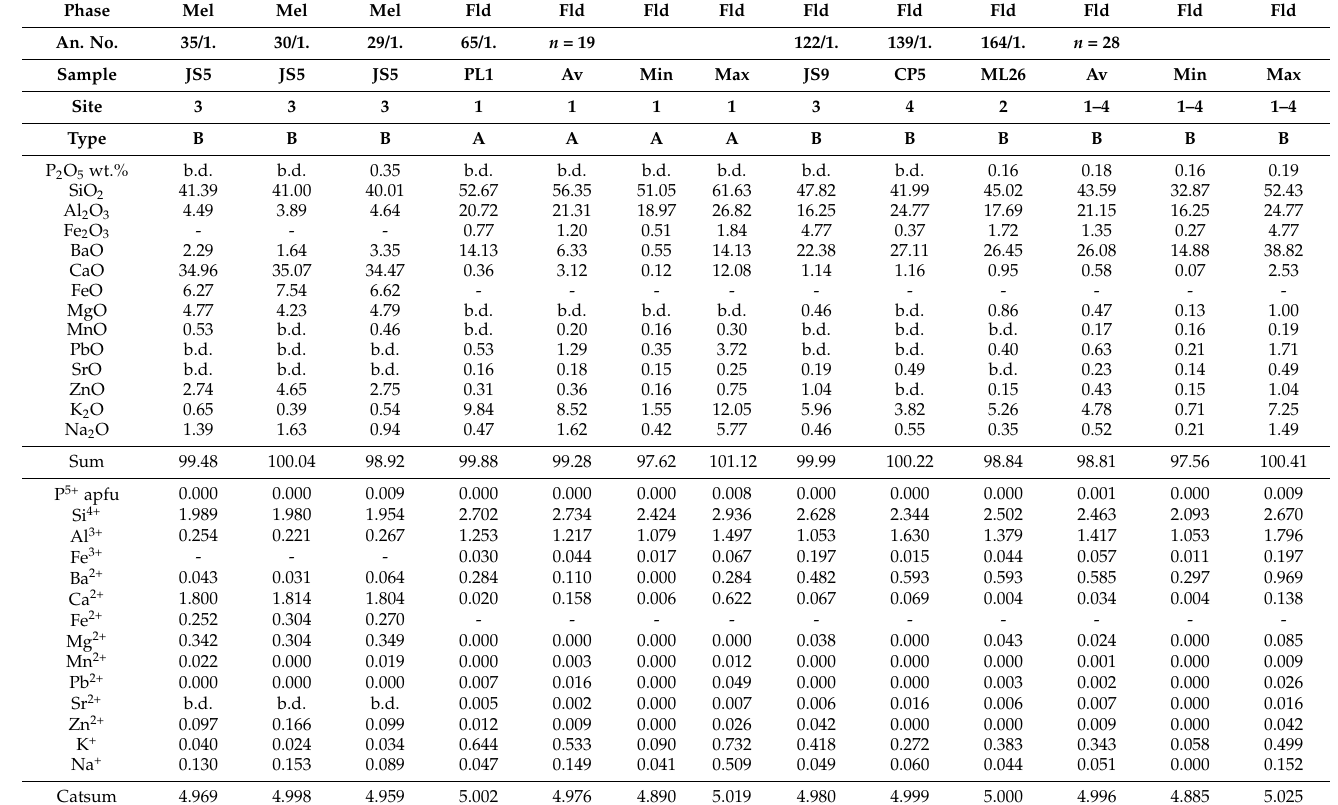
Table 4. Representative compositions of melilite and feldspar. The apfu values were calculated on the basis of 7 oxygens for melilite and 8 oxygens for feldspar. Av—average, b.d.—below the limit of detection, - not